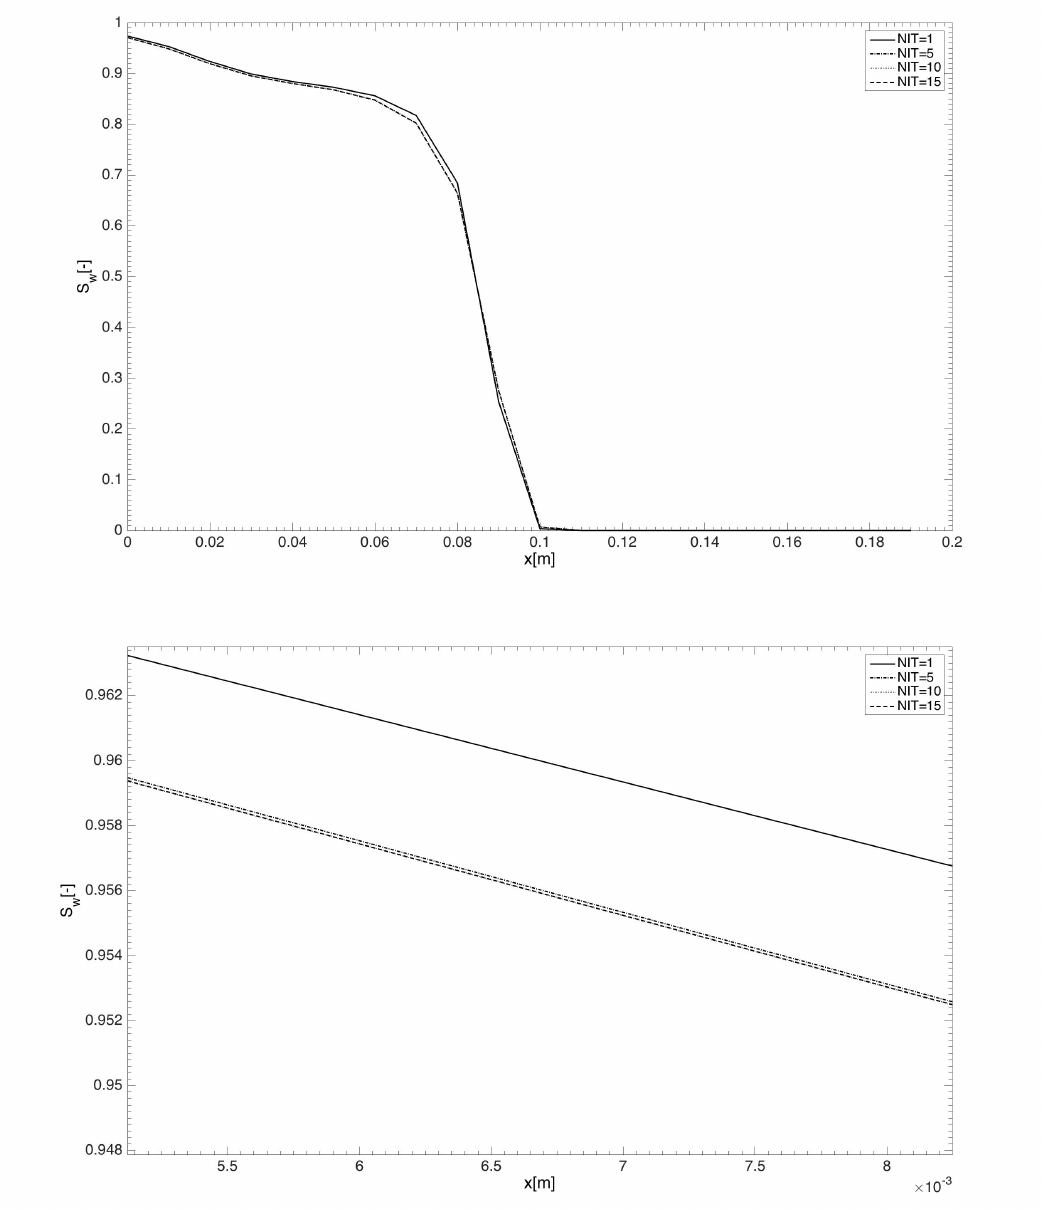
Figure 5. Saturation profiles at y = 0.01 m against x -axis for different number of iterations (NIT). The lower graph is scaled